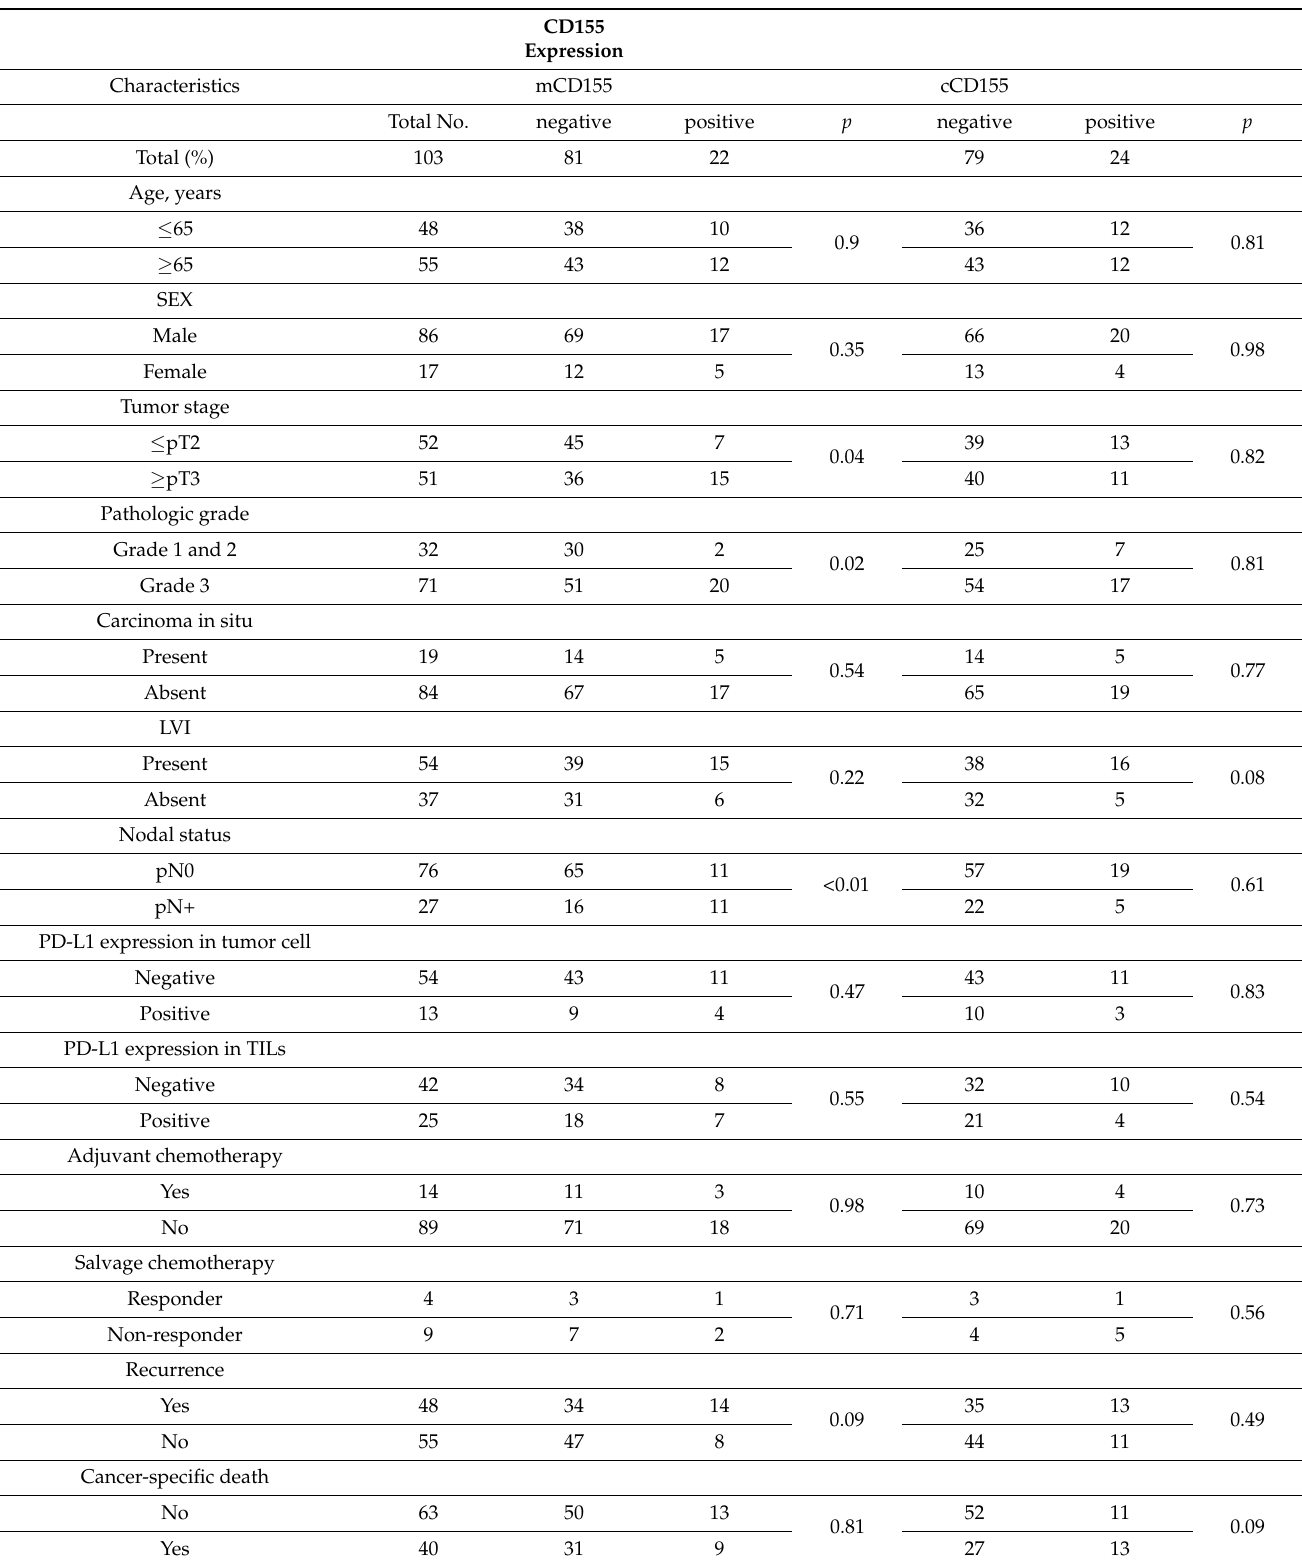
Table 1. Association of mCD155 expression with clinical and pathological